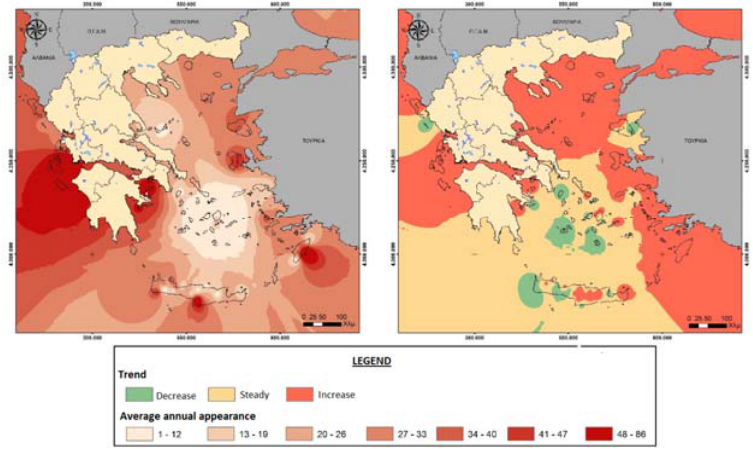
Figure 1. Heatwave frequency and rate.